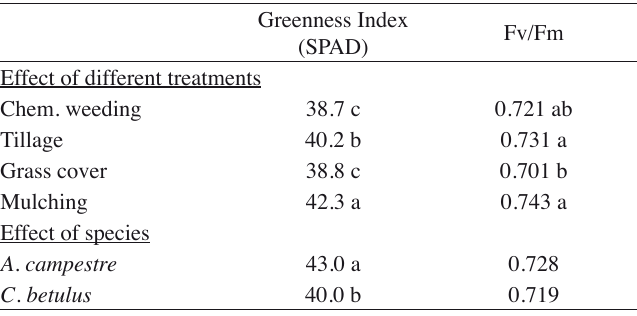
Table 4 - Effects of soil management technique and species on